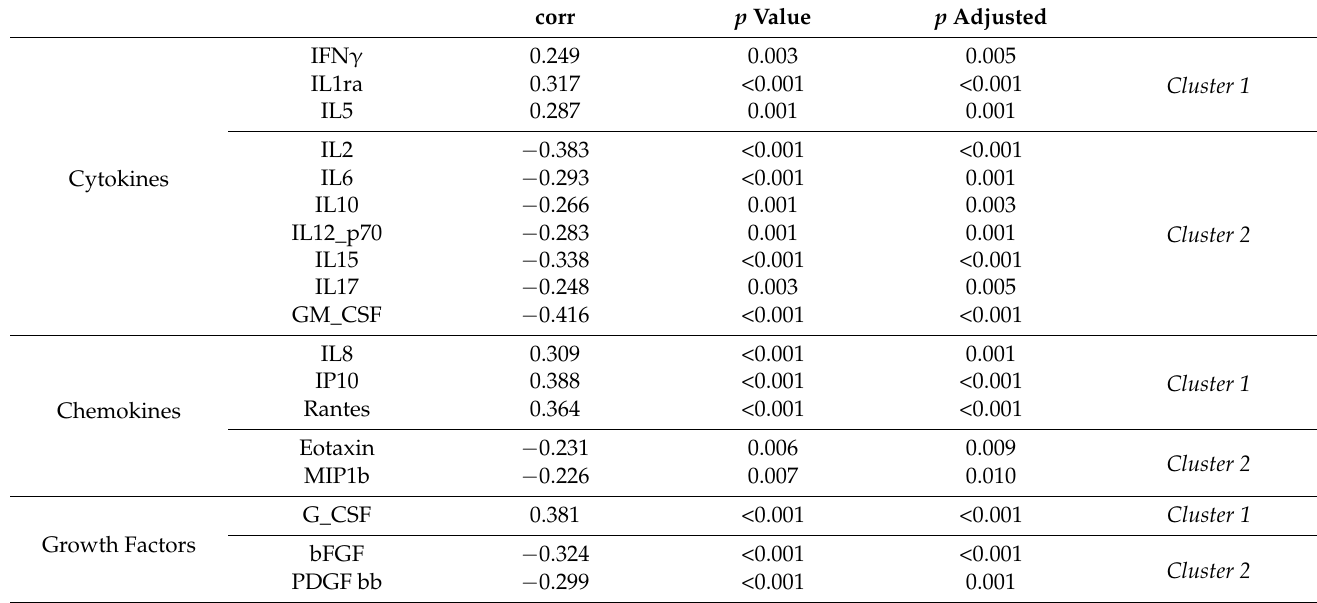
Table 3. Correlation between the levels of let-7b-5p and biochemical factors circulating in the CSF of patients with non-PMS at T0. corr p Value p